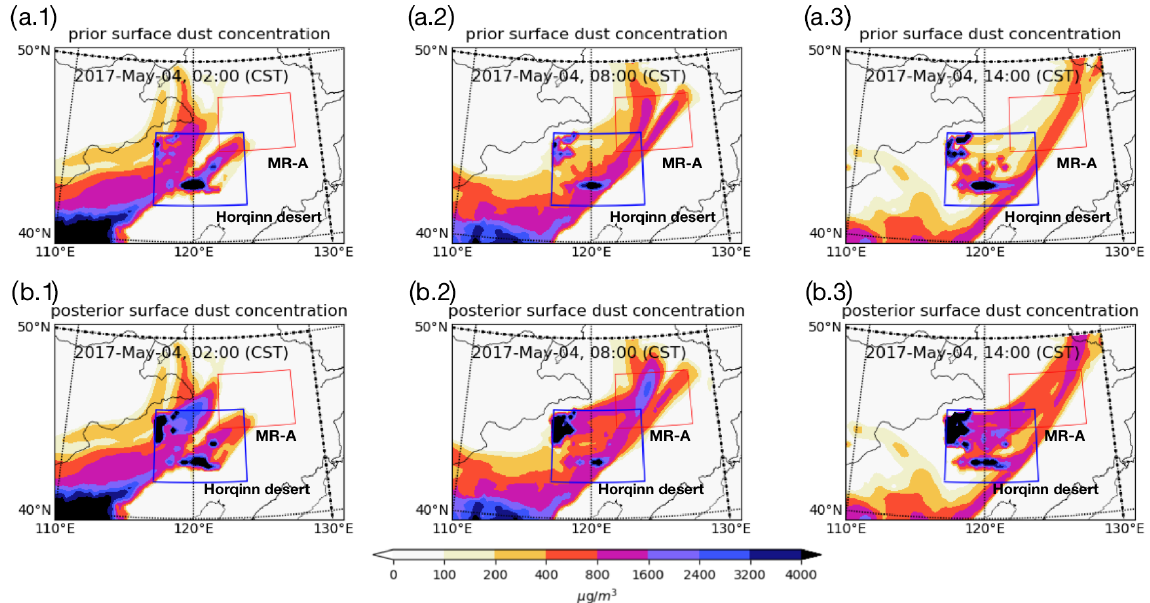
Figure 11. Simulation of SD2 using the new emission fields: (a) prior and (b) posterior (by assimilating the ground-based PM 10 observations) on 4 May, 02:00 (a.1–b.1) ; 08:00 (a.2–b.2) ; 14:00 (a.3–b.3) . MR-A: marked region